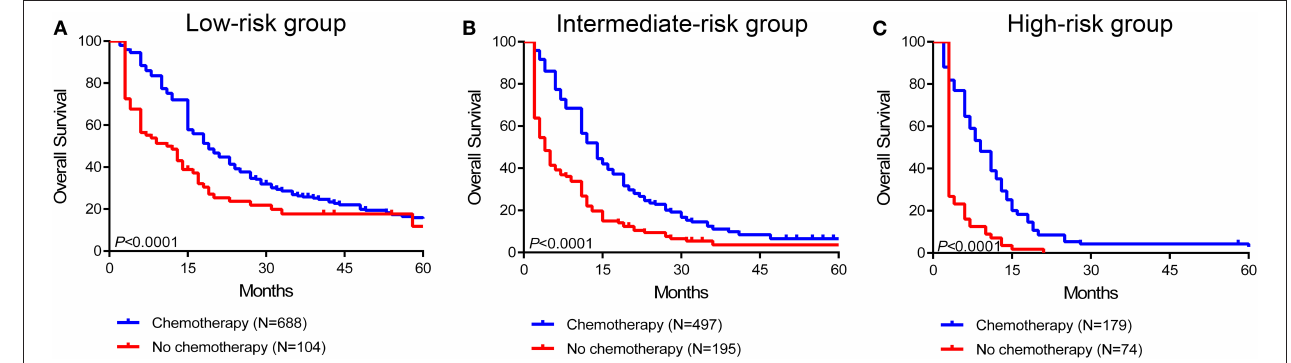
FIGURE 7 | Survival benefit of chemotherapy in the low-risk (A) , intermediate-risk (B) , and high-risk (C) groups.